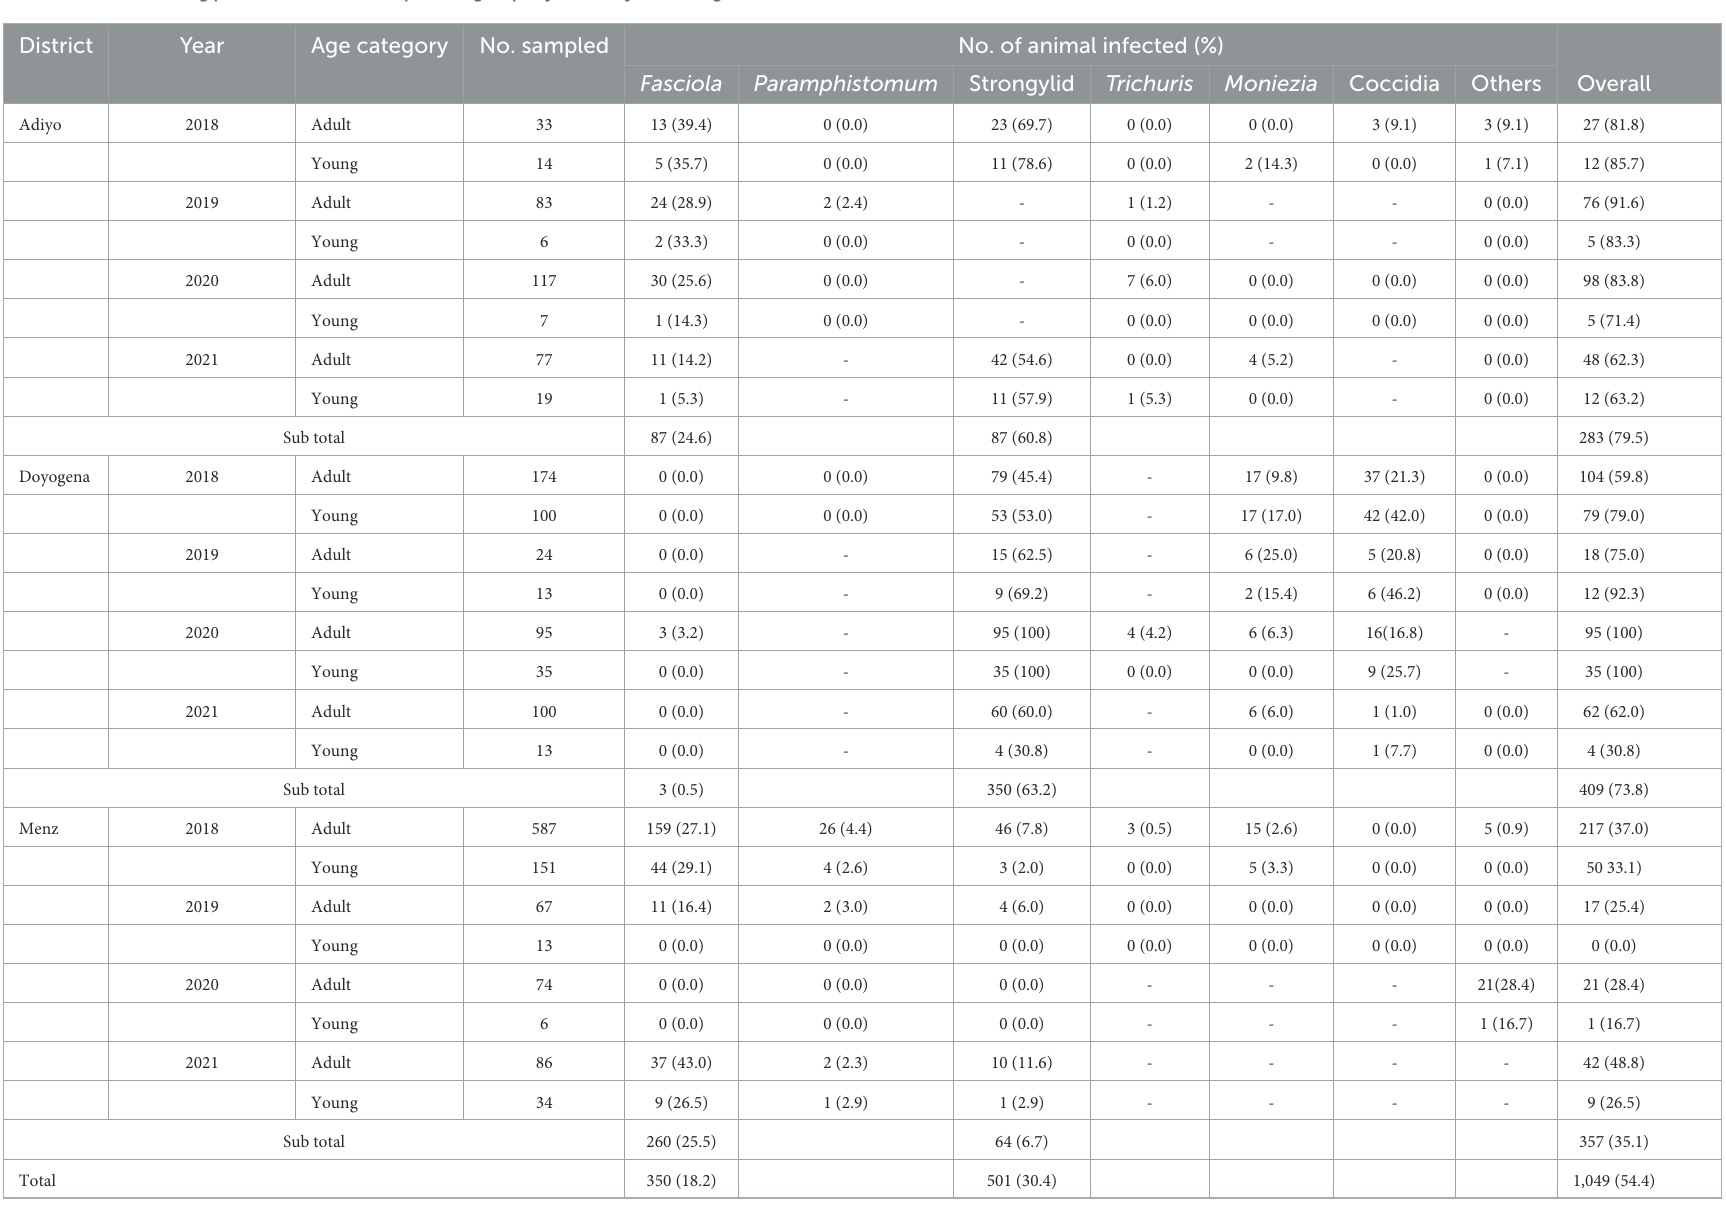
TABLE 2 Pre-deworming prevalence of different parasite groups by district, year, and age. District Year Age category No. sampled No. of animal infected (%) Fasciola Paramphistomum Strongylid Trichuris Moniezia Coccidia Others Overall Adiyo